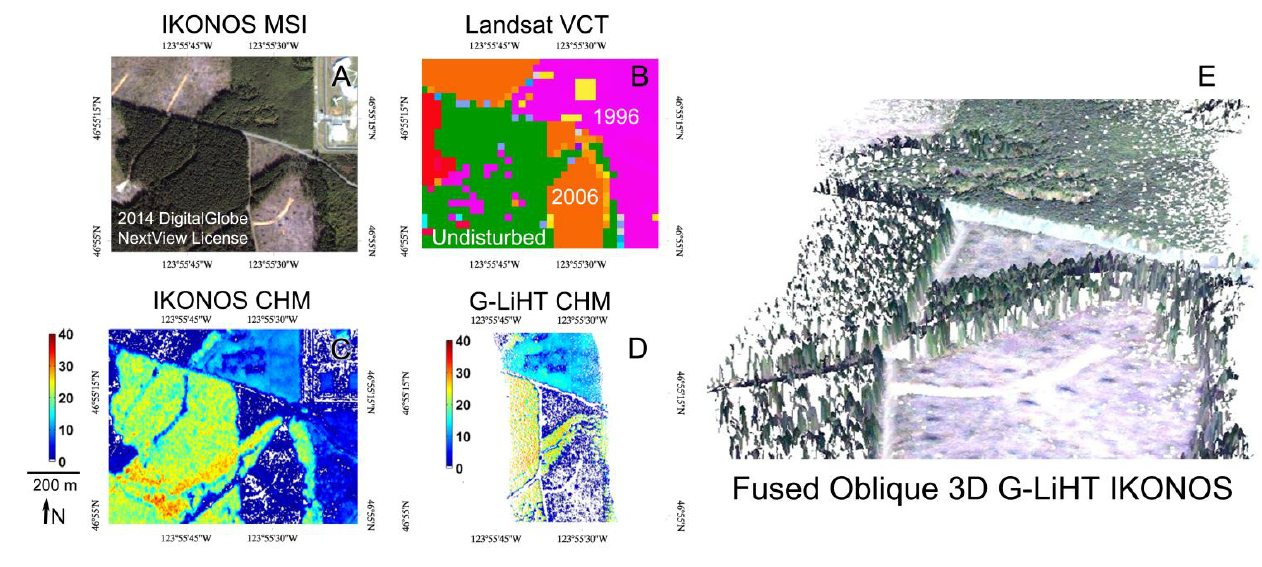
Figure 7. A comparison between IKONOS CHM and G-LiHT CHM near Hoquiam Washington south of Grays Harbor. ( A ) Pan sharpened multi-spectral image (MSI) true color IKONOS with patterns of even aged forest and clear cut harvest. ( B ) Landsat vegetation change tracker annual disturbance history from 1984 to 2010. ( C ) IKONOS CHM with 16 GCPs. ( D ) G-LiHT CHM. ( E ) Oblique 3-D image of IKONOS MSI fused with G-LiHT